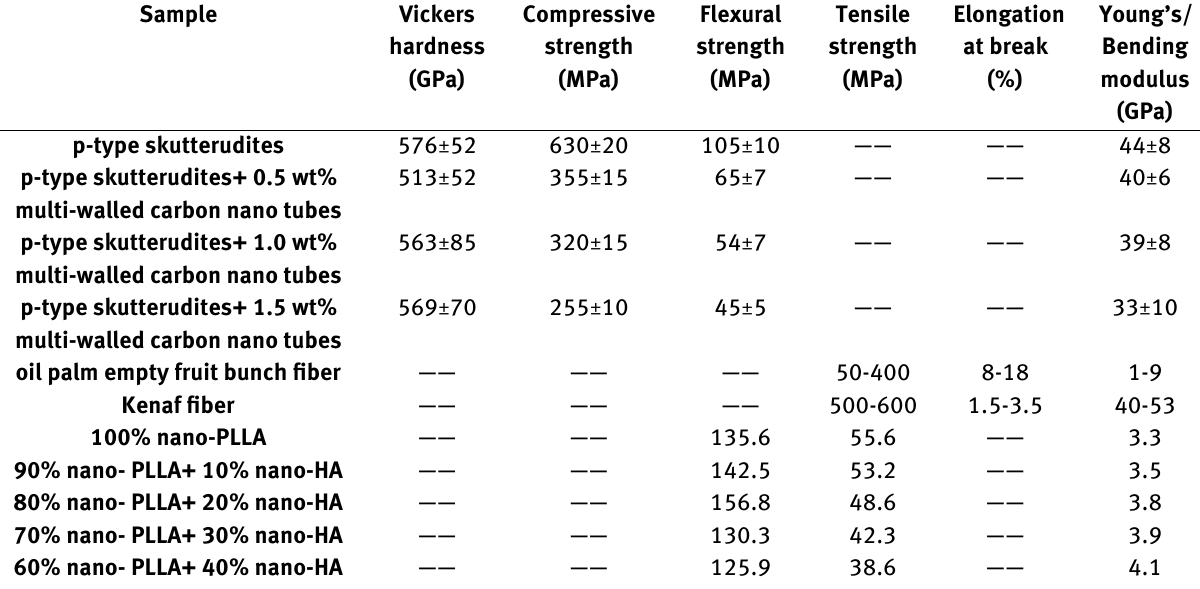
Table 4: Mechanical properties of non-metallic nanomaterials [51, 58, 59] Sample